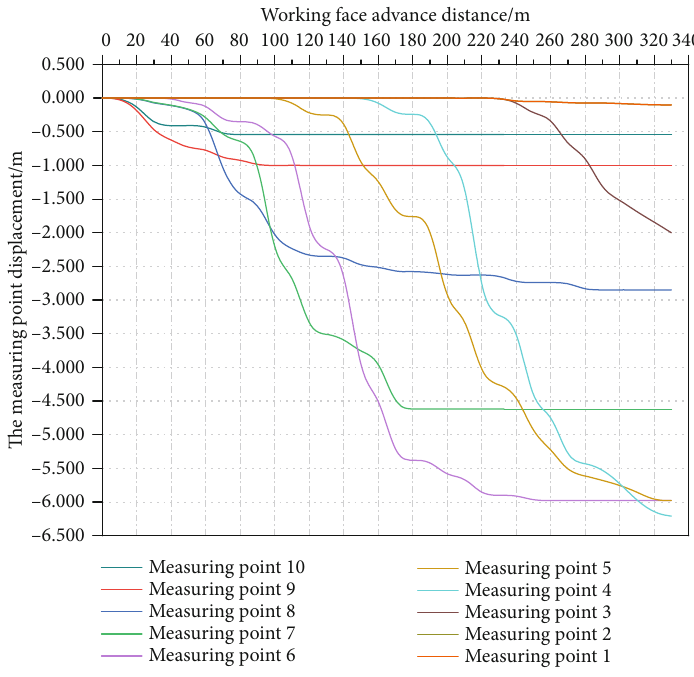
Figure 5: Measuring line 3 vertical displacement curve of each measuring point.